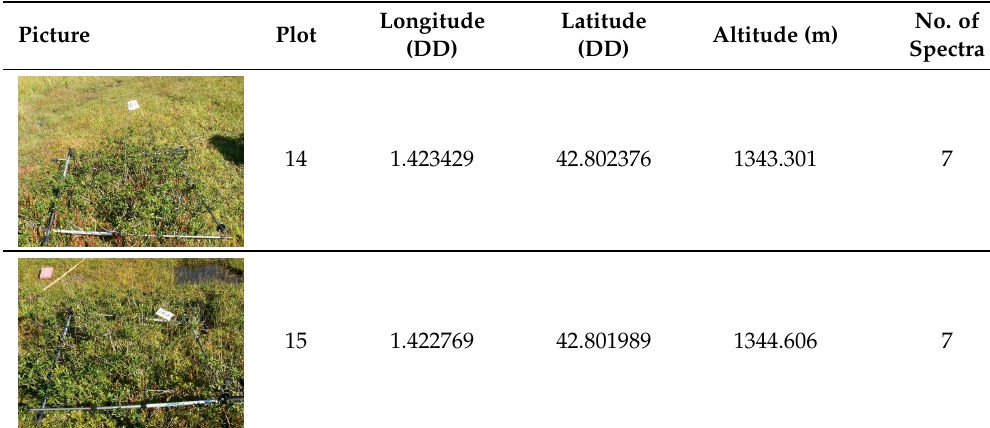
Table A8. Pictures, plots, geographic coordinates and number of spectra of Rhododendron ferrugineum (RHFR). Picture Plot